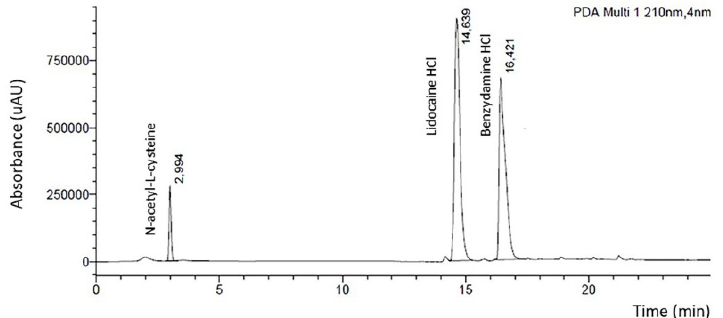
Figure 6. Fourier Transform Infrared Spectroscopy (FTIR) spectra of A-film (with drugs), P-film (without drugs), and pure drugs (Lidocaine HCl, Benzydamine HCl, and N -acetyl-L-cysteine) are shown.